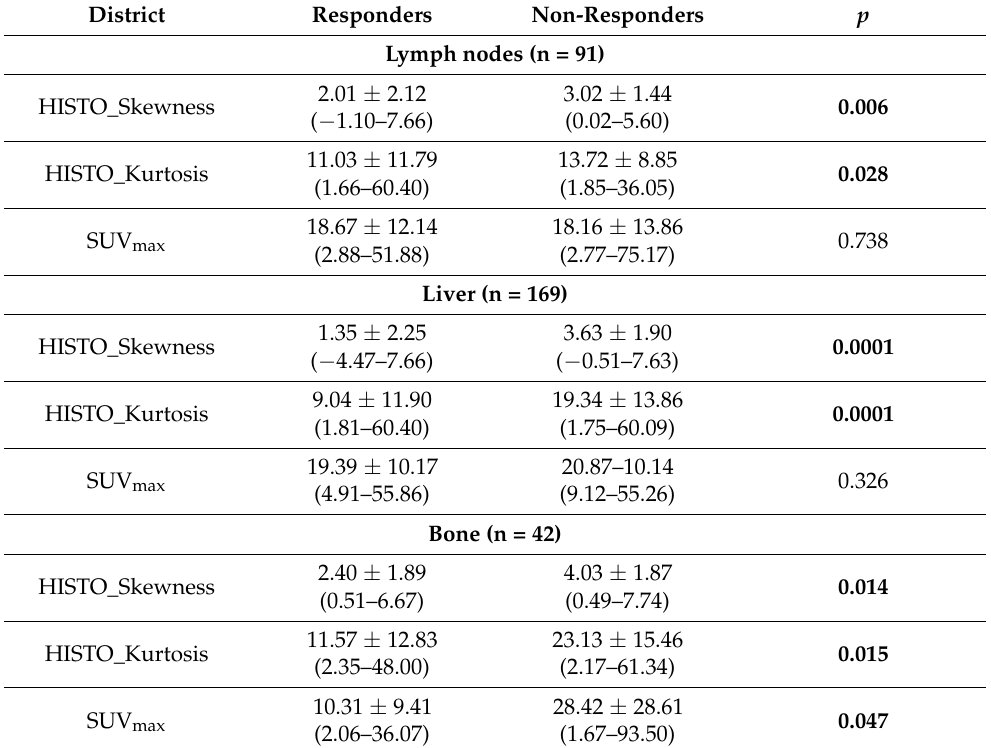
Table 2. The values of HISTO_Skewness, HISTO_Kurtosis, and SUV max (median ± DS, range) for responder and non-responder patients in the three main districts affected by the